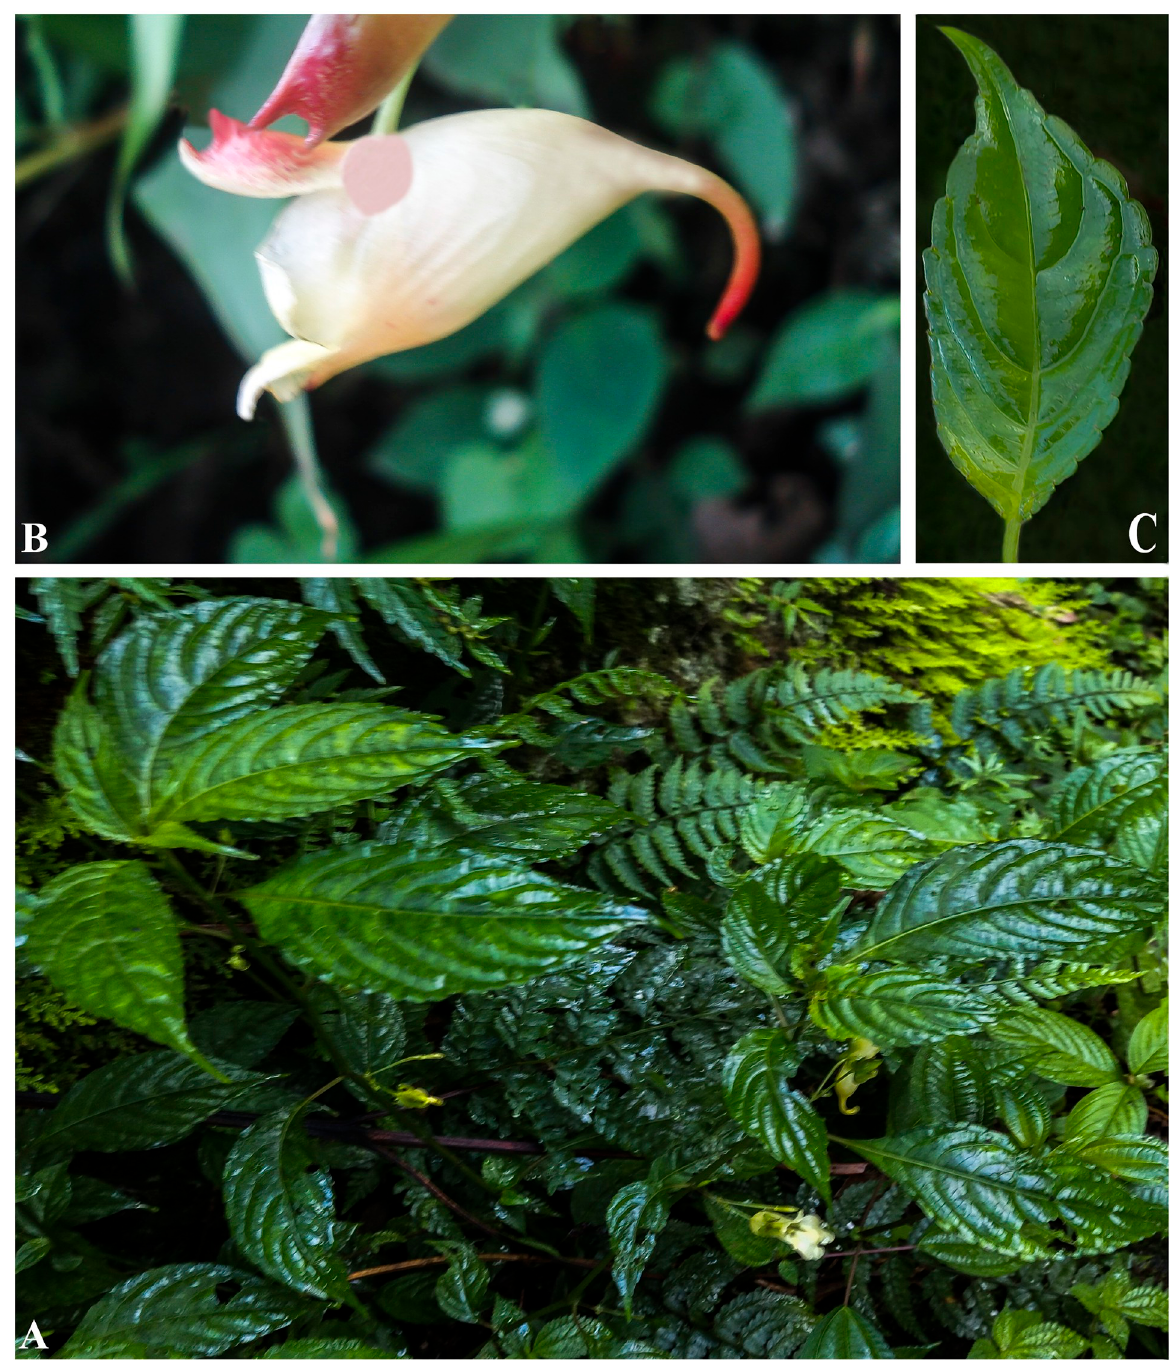
Fig 7. Impatiens cathcarthii A. Flowering plant; B. Side view of flower; C. Leaf. Photographs by Bhakta Bahadur Raskoti. et al . 771446 , (TI); Kathmandu district, Sheopuri, Chuma 7009224 (TI); Mangalbare, Hara et al . 6300497 (TI); Manglabare, 2650 m, Dobremez 1553 (BM); Milke Danda, 9000 ft., Beer 25740 (BM); Sati Khola, Peramchaw, 3500 ft., Stainton et al . 6495 (BM); Sankhuwasabha dis- trict, Tinjure Danda, 7500 ft., Williams & Stainton 8379 (BM); Kaski, Banthati, 2180 m, Mikage